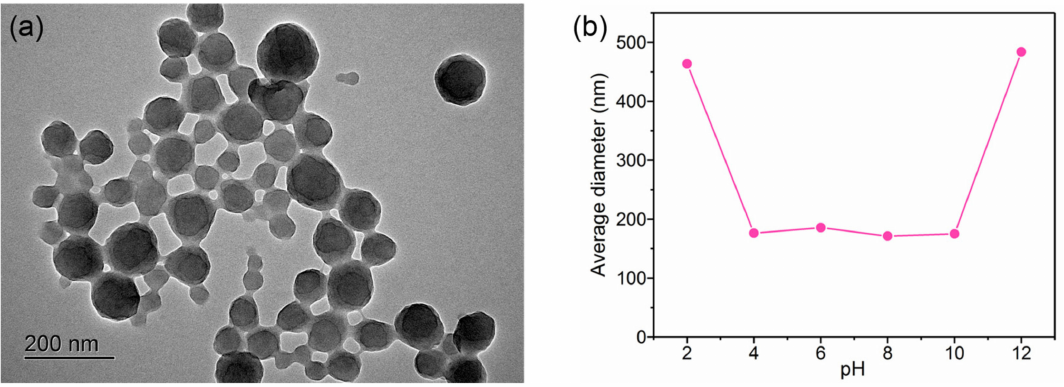
Figure 1. ( a ) TEM and ( b ) effect of pH on average hydrodynamic diameter of lignin